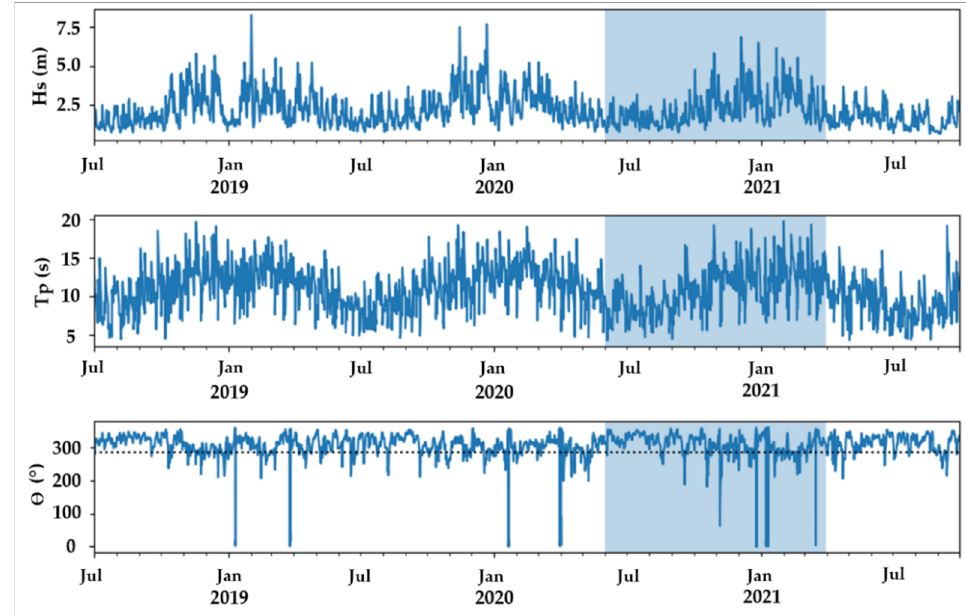
Figure 4. Time-series of deep-water parameters (Hs, Tp, Ө ) during the monitoring period (July 2018 to September 2021). The highlighted blue region corresponds to the period covered by the pre- and post-nourishment TBS (June 2020 to March 2021). The dotted line indicates shore normal direction.